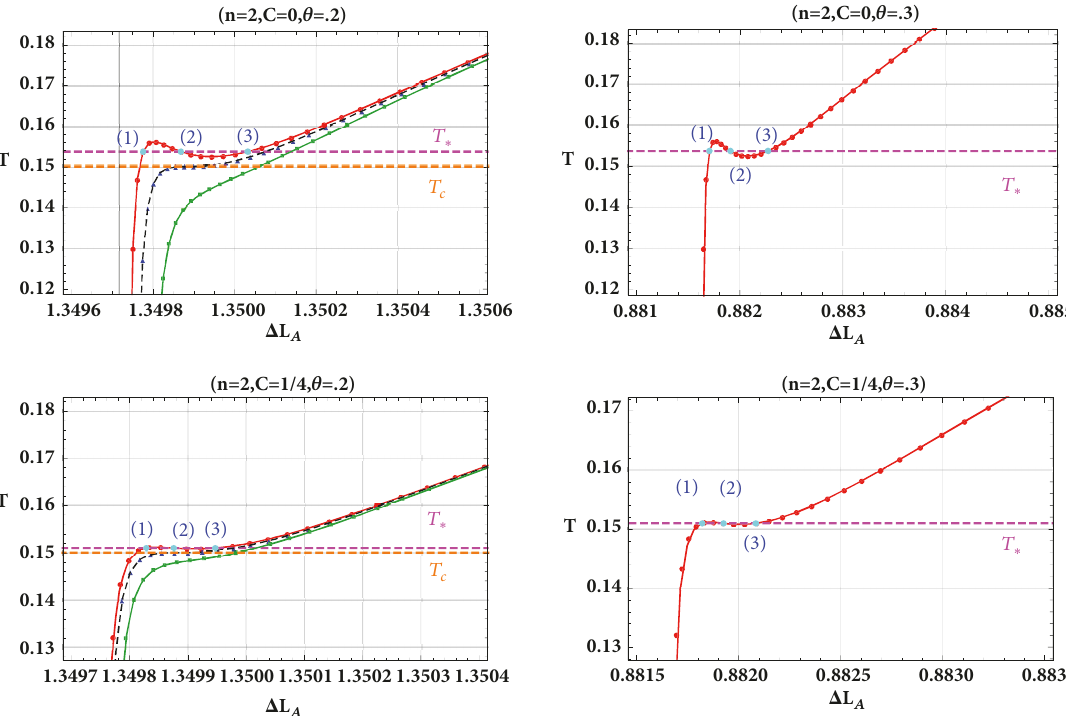
| for different 𝐶 . (Left) (Φ 𝑐